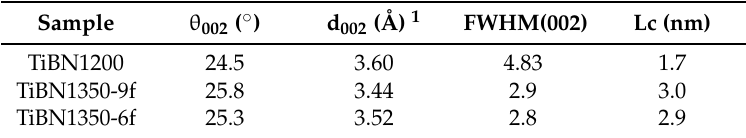
Table 1. Main XRD parameters obtained for samples TiBN1200, TiBN1350-9f and